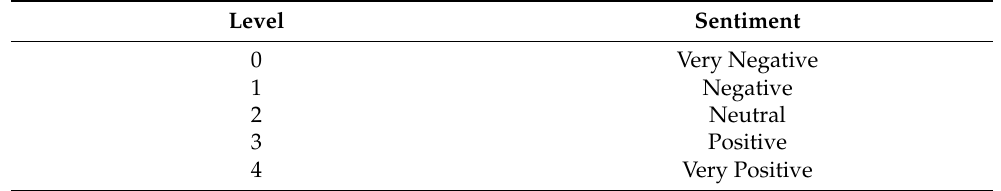
Table 1. Sentiment Analysis Levels.